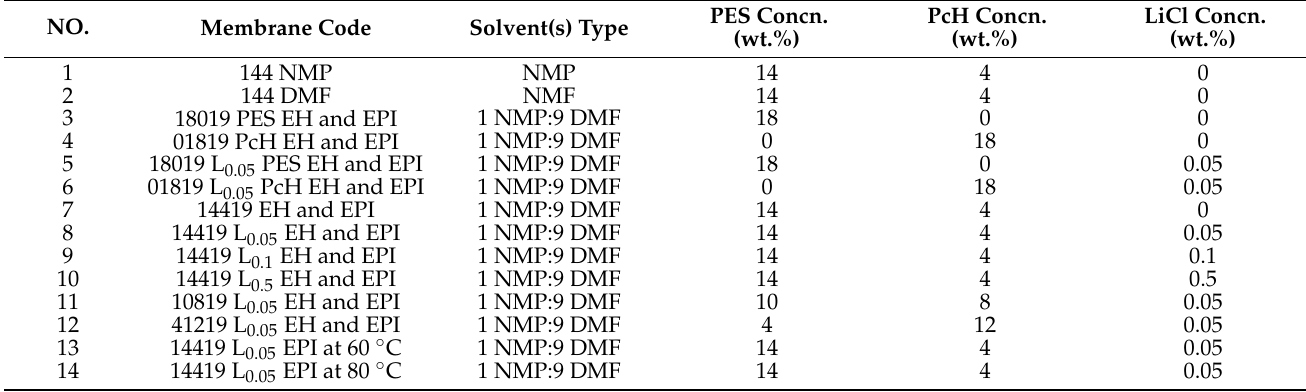
Table 1. Coded name and composition of the fabricated